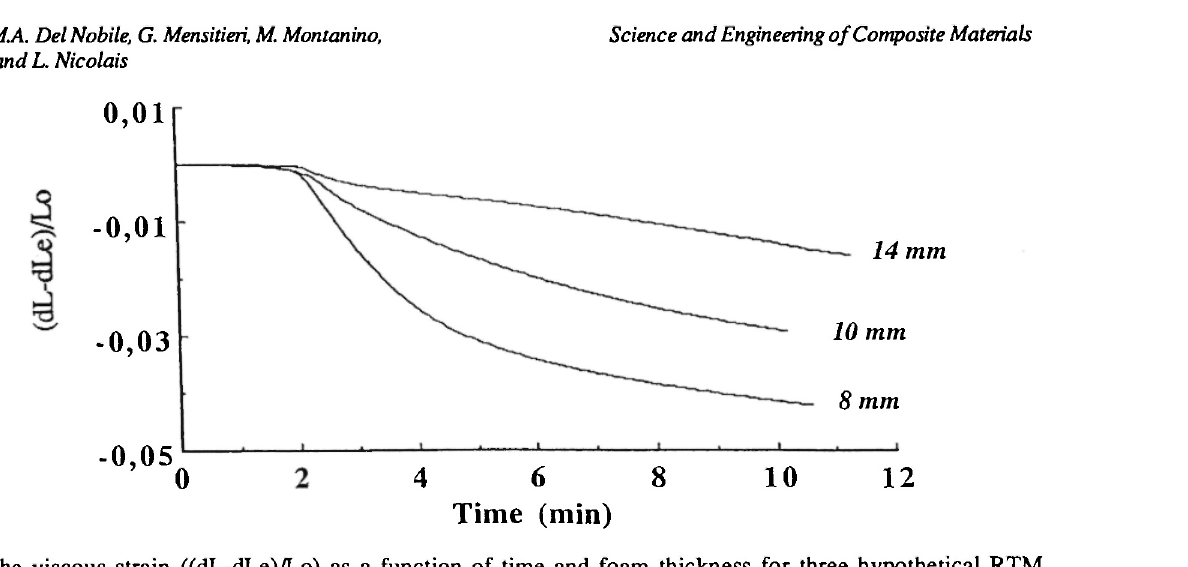
Fig. 8: The viscous strain ((dL-dLe)/Lo) as a function of time and foam thickness for three hypothetical RTM moldings (where dL is the total foam deformation, dLe is the initial deformation, and Lo is the initial thickness).